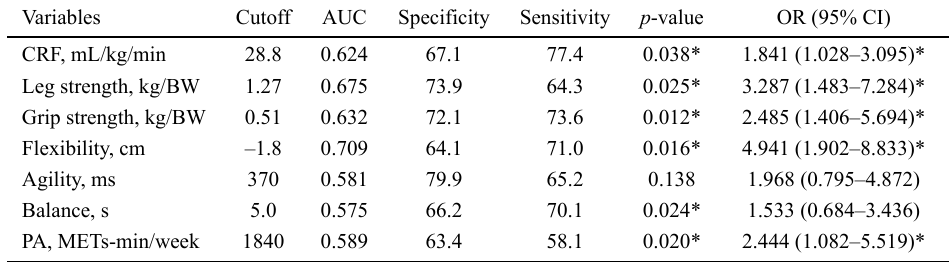
Table 3. Cut off value and odds ratio of fitness factor and physical activity to decrease the VFA.